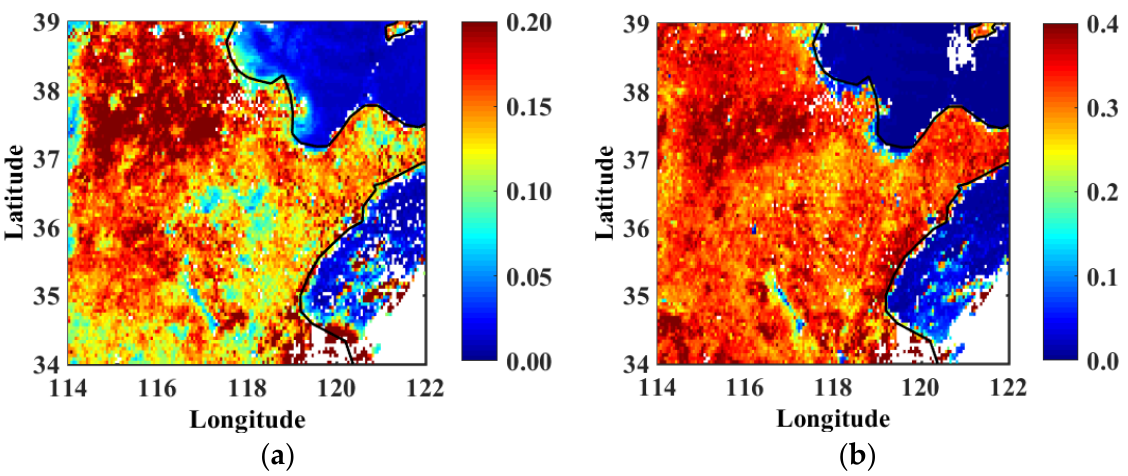
Figure 7. ( a – c ) are the AHI near-infrared band reflectance at 00:00 UTC, 02:00 UTC and 04:00 UTC on 1 July 2019 computed from MCD43 coefficient, respectively. ( d – f ) correspond to the reflectance after atmospheric correction. ( g – i ) are the reflectance after both atmospheric and angle corrections.